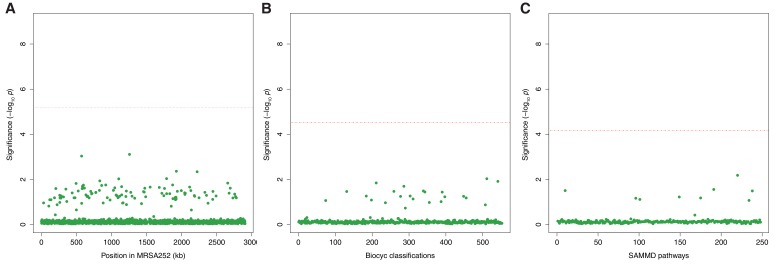
Genes, ontologies and pathways enriched for protein-altering variants among longitudinally sampled asymptomatic nasal carriers.(A) Significance of enrichment of 2650 individual genes. (B) Significance of enrichment of 552 gene sets defined by BioCyc gene ontologies. (C) Significance of enrichment of 248 gene sets defined by SAMMD expression pathways. Genes, pathways and ontologies that approach or exceed a Bonferroni-corrected significance threshold of α = 0.05, weighted for the number of tests per category, (red lines) are named.